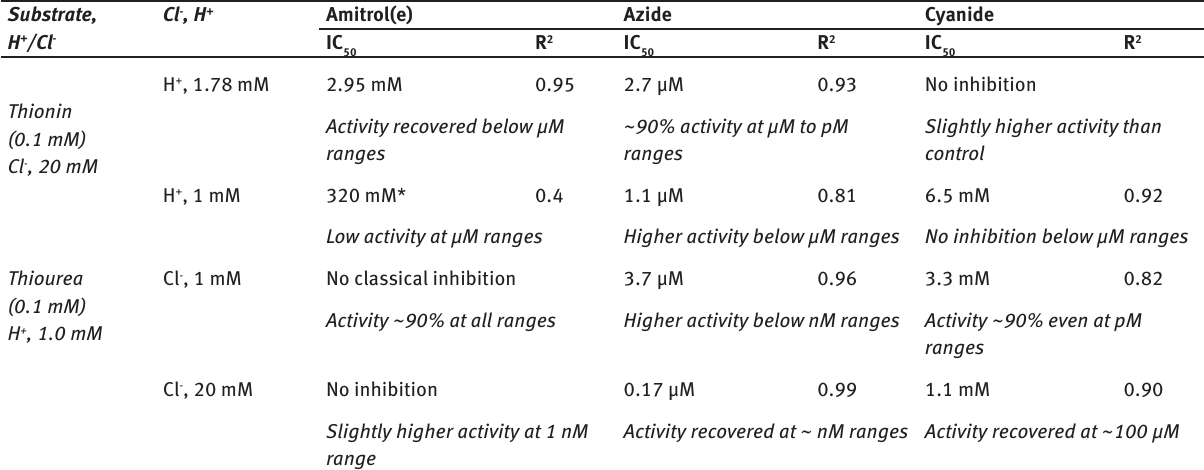
Table 5: Effect of various Type II ligands (including CN) and pH/ion concentration on the chlorination of thionin and thiorea by chloroperoxidase. The (purported active site ligand) additives showed highly concentration dependent inhibition and at times, inexplicable activation effects. The non-linear regression analyses showed many times poor fits (with much lower values for R 2 , if sub-nanomolar values were also taken for IC calculation), implying the global inapplicability of classical theoretical foundations. 50